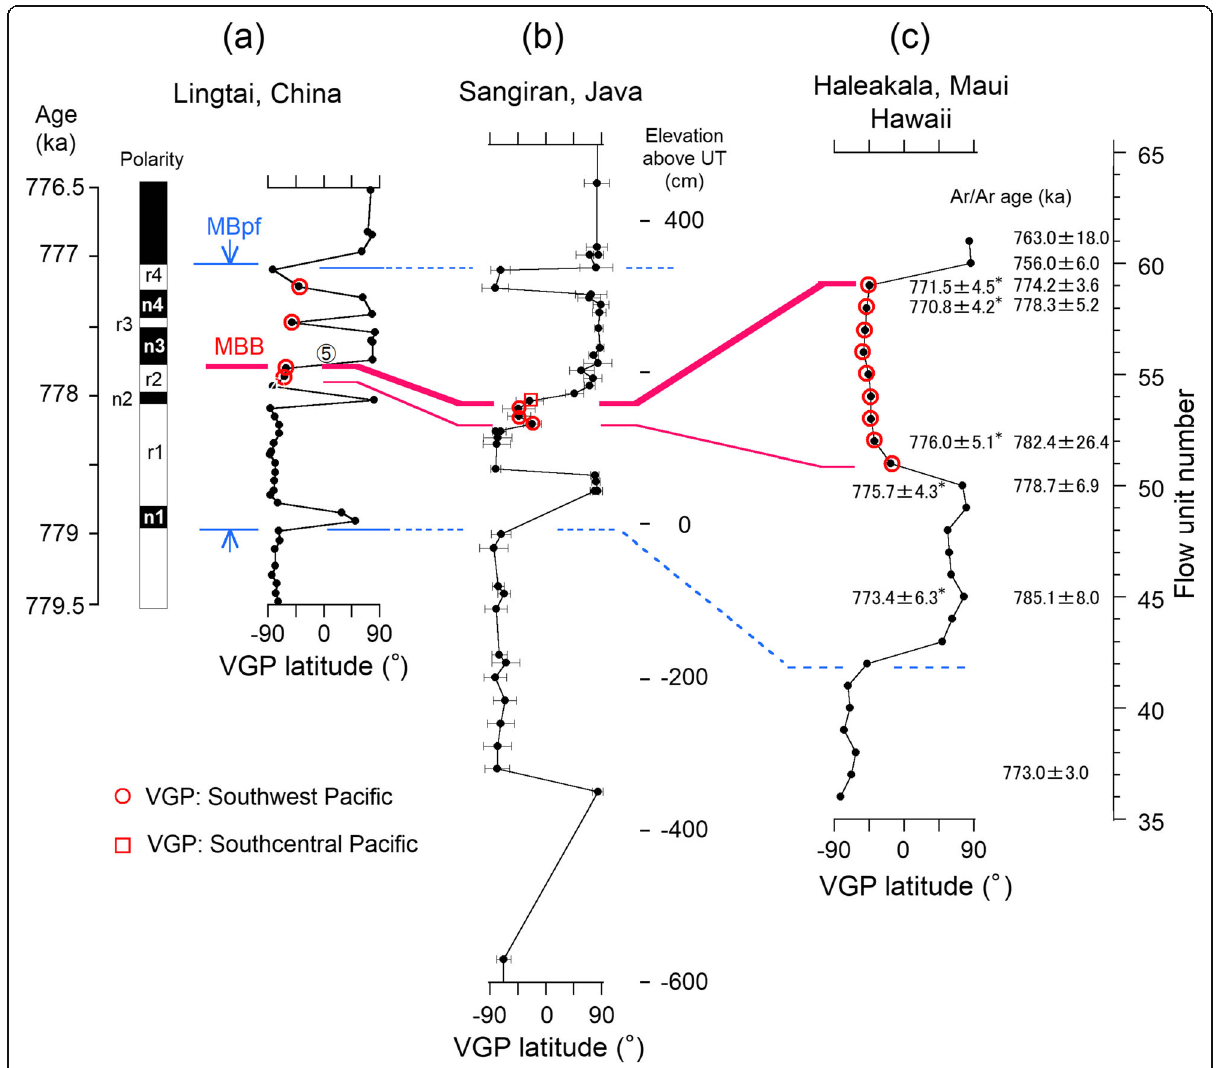
Fig. 8 Comparison of terrestrial sequence records of the MB transition VGPs. a The age plot of the VGP latitudes around the MB polarity flip (MBpf) zone from Lingtai. The short polarity zones in the MBpf are numbered “ n1 – n4 ” for normal polarity and “ r1 – r4 ” for reverse polarity in ascending order. Polarity flip no. 5 is after Fig. 7a. b The elevation plot of the VGP latitudes of a horizon mean paleomagnetic direction with an error bar of α 95 from Sangiran, Java (After Hyodo et al. 2011). UT: Upper Tuff. c The VGP latitudes from lavas of the Haleakala section on Maui Island, Hawaii (after Coe et al. 2004), plotted to the flow unit number. The Ar/Ar ages with an asterisk are after Singer et al. (2019). The thick and thin red lines show the correlations for the upper and lower boundaries of the SW Pacific VGP zone, respectively. MBB: the main MB